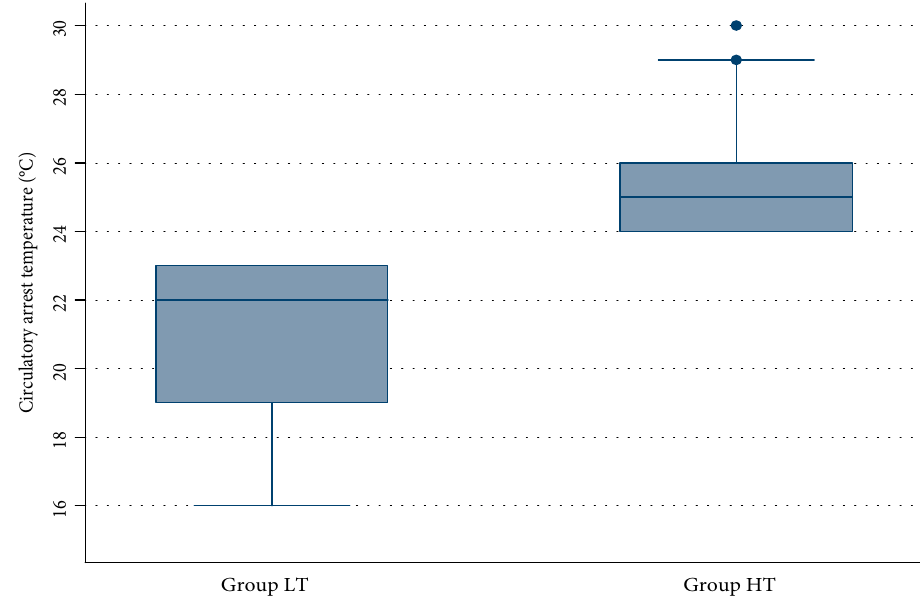
Figure 1: Box plot showing distribution of temperature over our